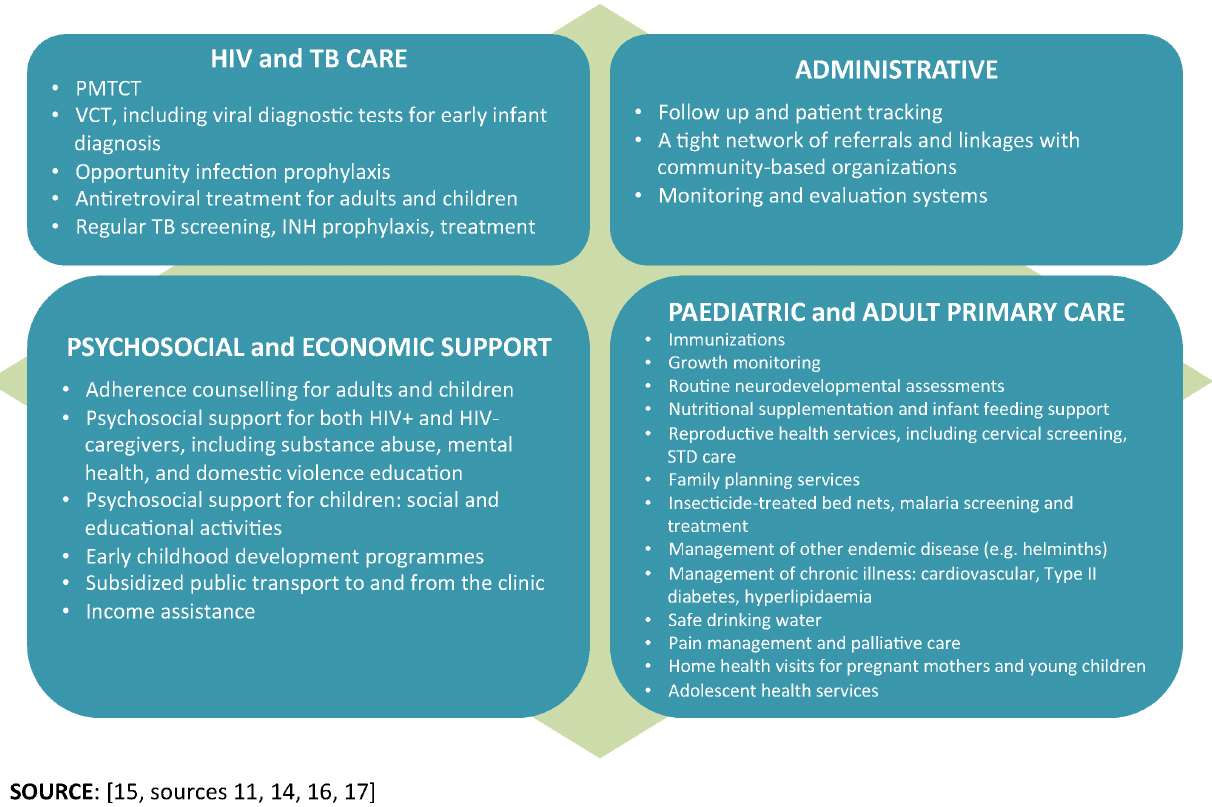
Figure 1. Possibilities for integrated service package for family-centred care. Figure displays recommended services listed within four sub- headings: HIV and TB care, paediatric and adult primary care, psychosocial and economic support, and administrative services.